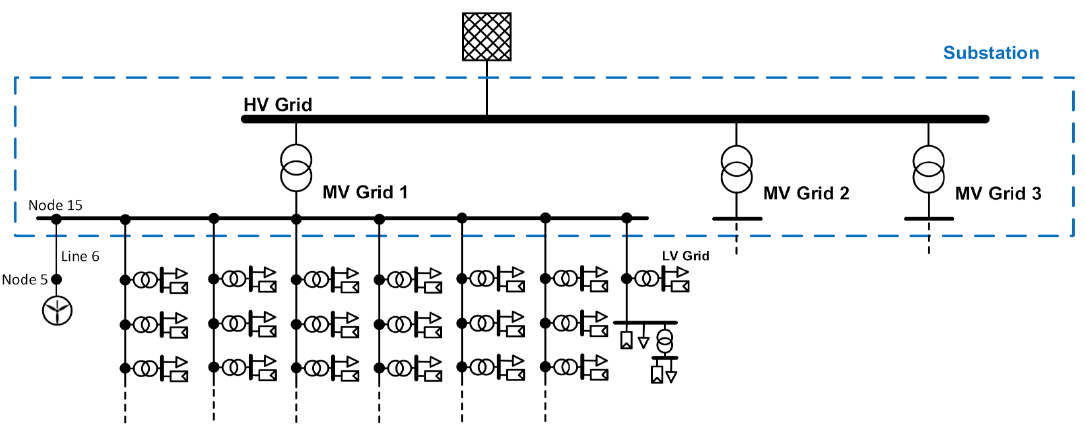
Figure 4. Simplified demonstrative illustration of the considered MV